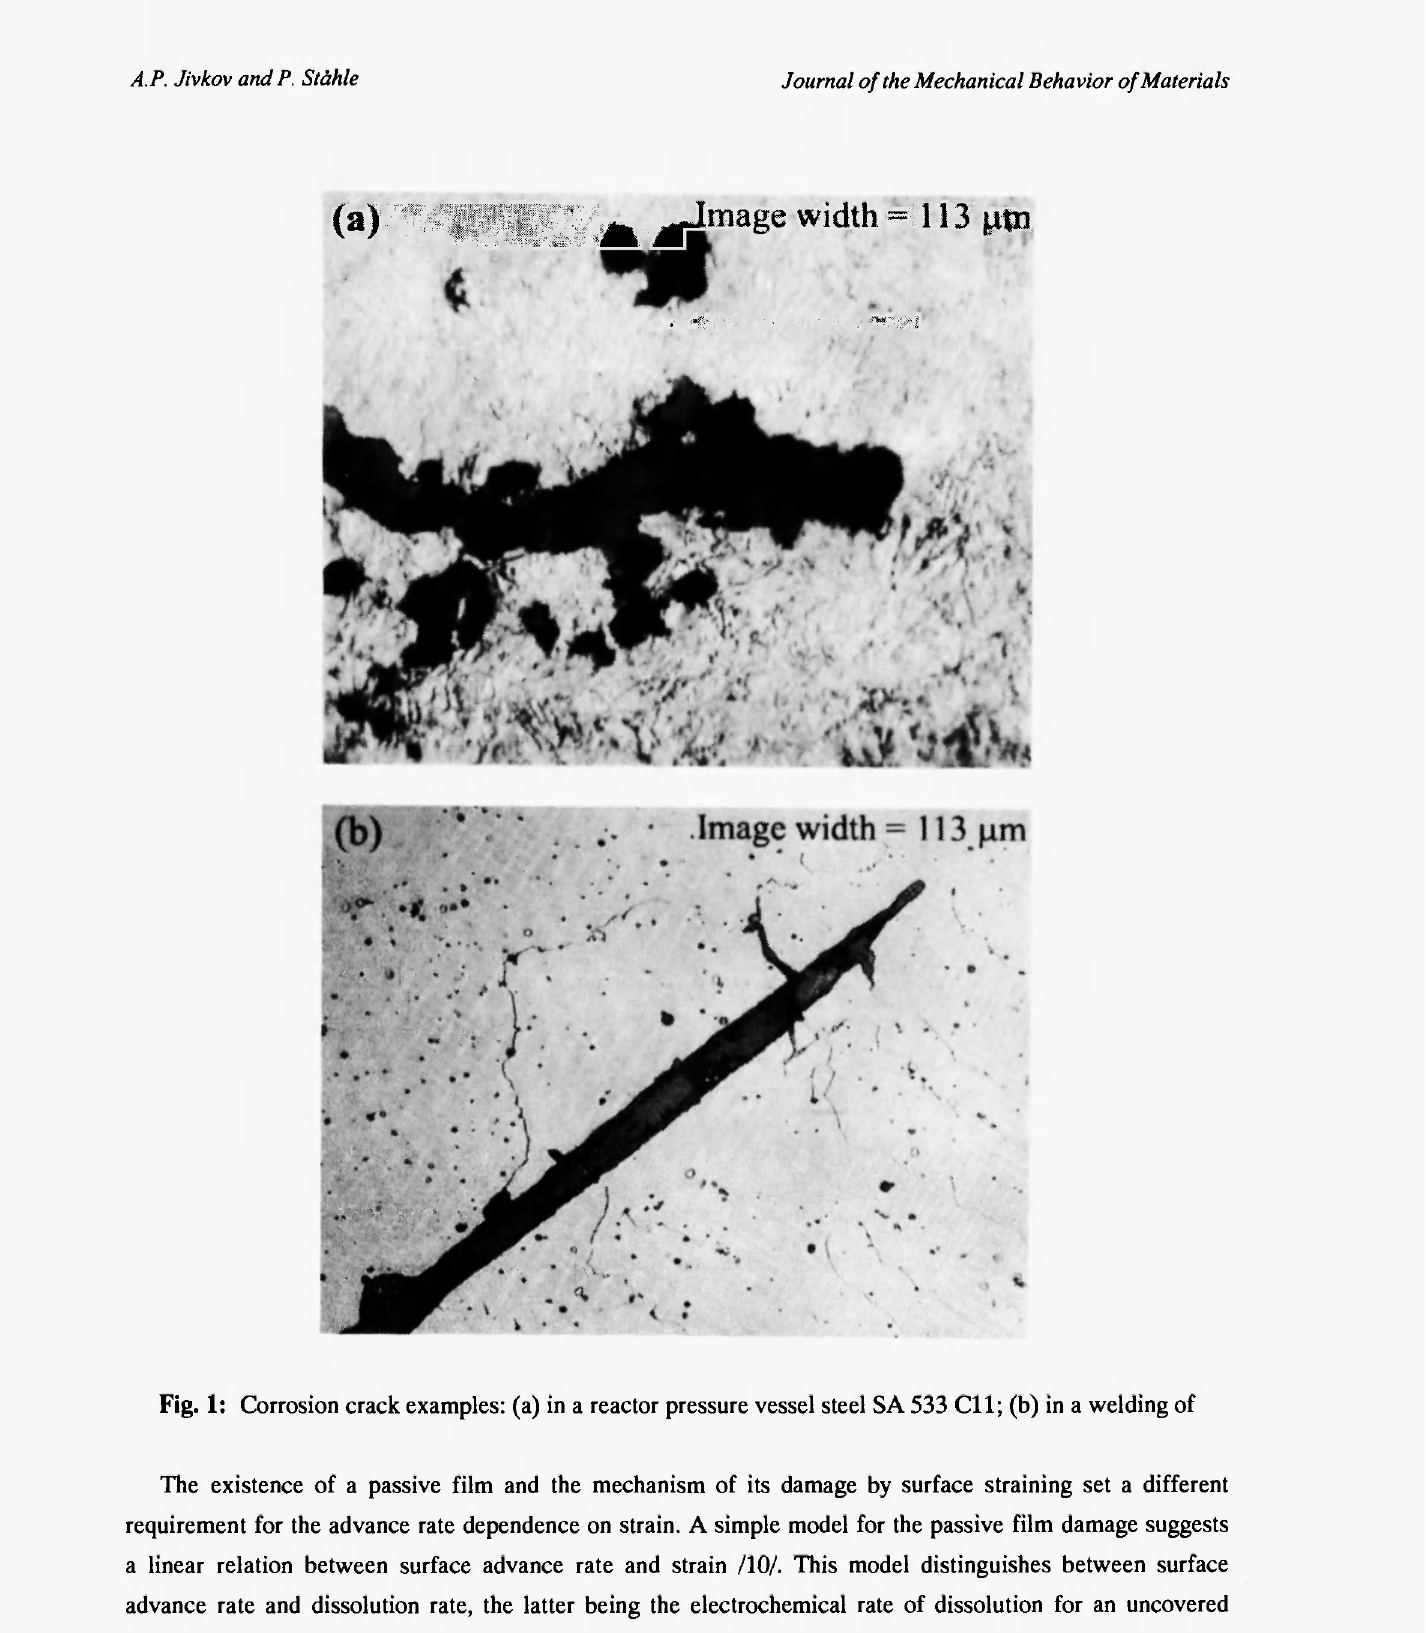
The existence of a passive film and the mechanism of its damage by surface straining set a different requirement for the advance rate dependence on strain. A simple model for the passive film damage suggests a linear relation between surface advance rate and strain /10/. This model distinguishes between surface advance rate and dissolution rate, the latter being the electrochemical rate of dissolution for an